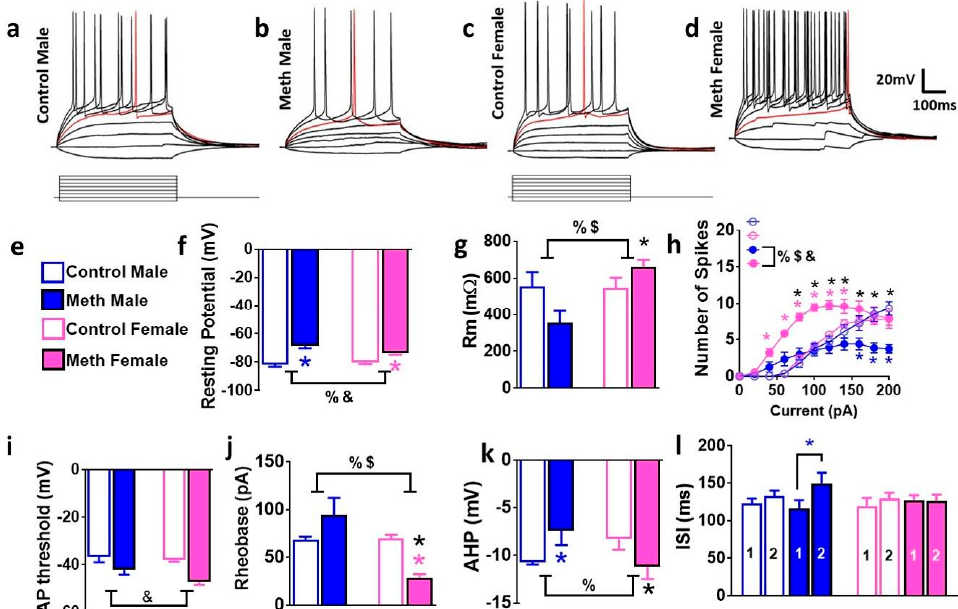
Figure 3. Electrophysiological properties of granule cell neurons (GCNs) are distinctly altered in male and female rats. ( a–d ) Representative traces of action potentials elicited by depolarizing current injections. Traces were recorded from GCNs from control male ( a ), methamphetamine male ( b ), control female ( c ), and methamphetamine female ( d ) rats. ( e ) Legends for bar graphs. ( f–l ) Comparison of intrinsic and active membrane properties. Analysis across all cells indicated that under baseline conditions resting potential ( f ) and membrane resistance ( g ) showed a significant sex × treatment interaction. ( h ) Graphical relationship between the number of spikes elicited by increasing current injections in current-clamp recording. ( i–l ) Analysis of electrophysiological properties indicate that AP threshold, rheobase, AHP, and inter-spike interval (ISI) showed significant interaction or main effect of sex or methamphetamine. Data shown are represented as mean ± SEM. Control males, n = 8 cells; control females, n = 6 cells; reinstated males, n = 12 cells; reinstated females, n = 19 cells. %, significant sex × reinstatement interaction; $, main effect of sex; * p < 0.05 vs. control males; * p < 0.05 vs. reinstated males; * p < 0.05 vs. control females by post-hoc tests.